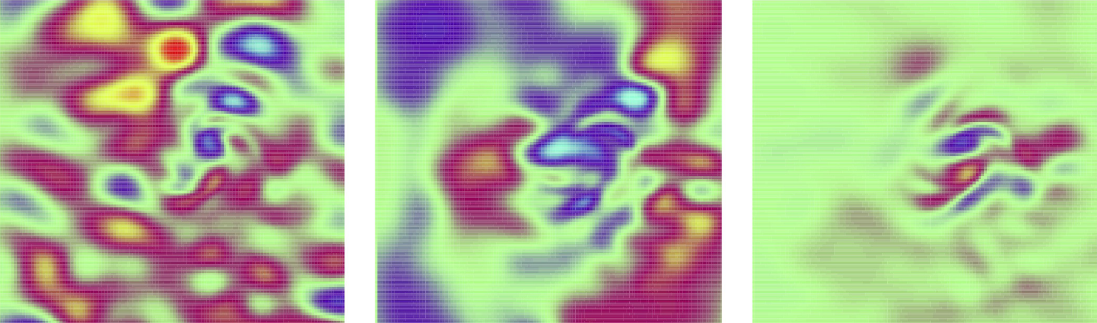
Figure 8. Error between the true velocity v and the analysed velocity after assimilation of an observation sequence with strong spatially correlated additive noise, with 9% missing observation points. The color scale ranges from − 0.01 m.s − 1 ( blue ) to 0.01 m.s − 1 ( red ), which amounts to a third of the maximum velocity (ranging from − 0.028 m.s − 1 to 0.028 m.s − 1 ). Left: result for the pixel method, middle: wavelet without modification, right: improved wavelet